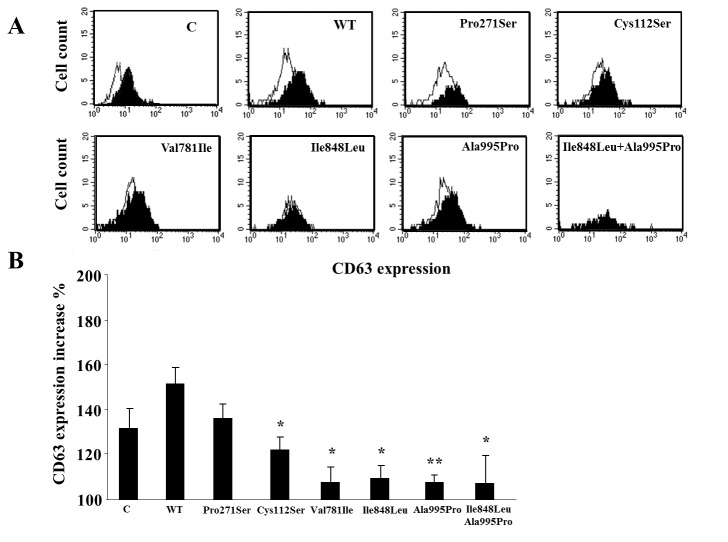
Functional effect of the “private” missense variations of UNC13D.HMC-1 cells were transiently transfected with wild-type (WT) UNC13D and mutated forms carrying the (p.Cys112Ser, p.Val781Ile, p.Ile848Leu, p.Ala995Pro, p. Ile848Leu/p.Ala995Pro, and p.Pro271Ser) variations (C = untransfected cells). Twenty-four hours after transfection, cells were teated (or not) for 10 min with fMLP, and expression of CD63 was evaluated by flow cytometry. [A] Cytofluorimetric histograms of CD63 expression in fMLP-stimulated (black) and unstimulated (white) cells transfected with each construct; one experimental representative of six is shown. [B] Mean and SE of the fMLP-induced expression of CD63 from six experiments; results are relative to the CD63 expression displayed by unstimulated cells (set at 100%) in each experiment; the asterisk marks the statistically significant difference versus cells transfected with the WT form; *p<0.05; **p<0.01 vs MUNCwt transfected cells.